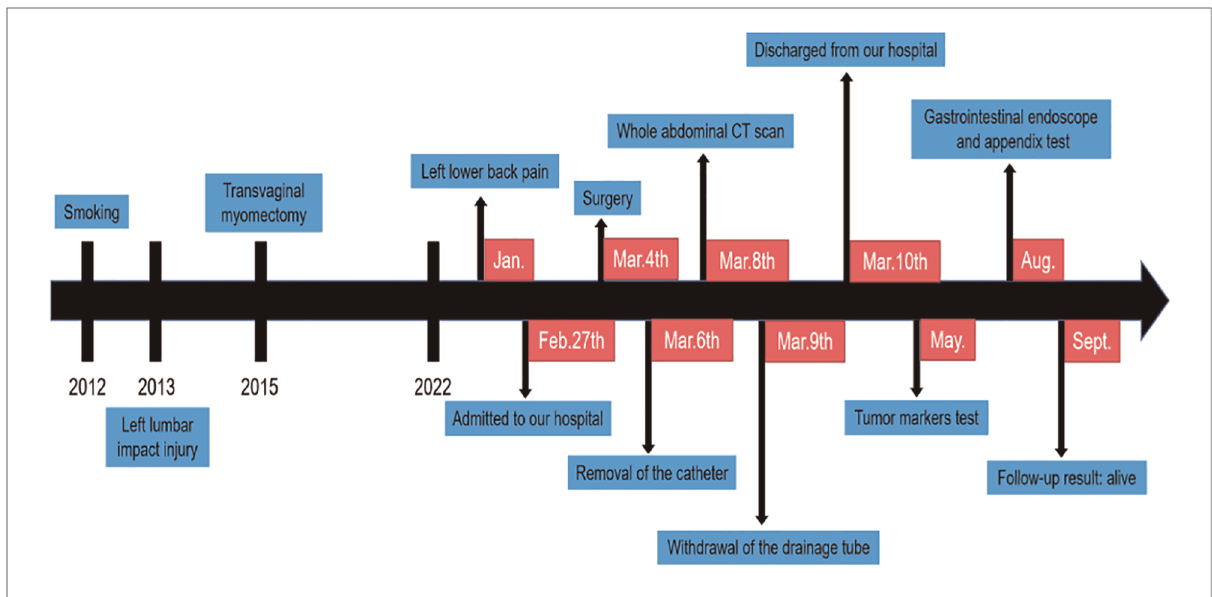
FIGURE 4 Timeline of the historical and current information from this episode of